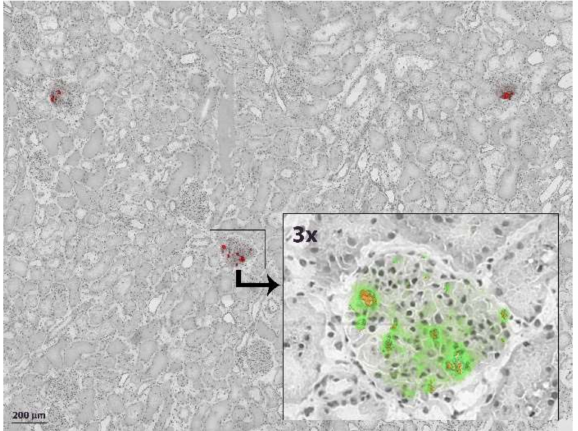
Figure 2. Glomerular PKH and Qtracker-625 fluorescence in cortical tissue after NMP with 10 7 MSCs added. Both fluorescent channels combined (red) in overview, showing that most glomeruli were negative and only a minority of glomeruli were positive for infused pre-labelled MSCs. In addition, some positive glomeruli contained more than one MSC. Inset shows a 3x magnified confocal fluorescence microscopy image with emission wavelengths of both dyes separated: PKH = green, Qtracker-625 =